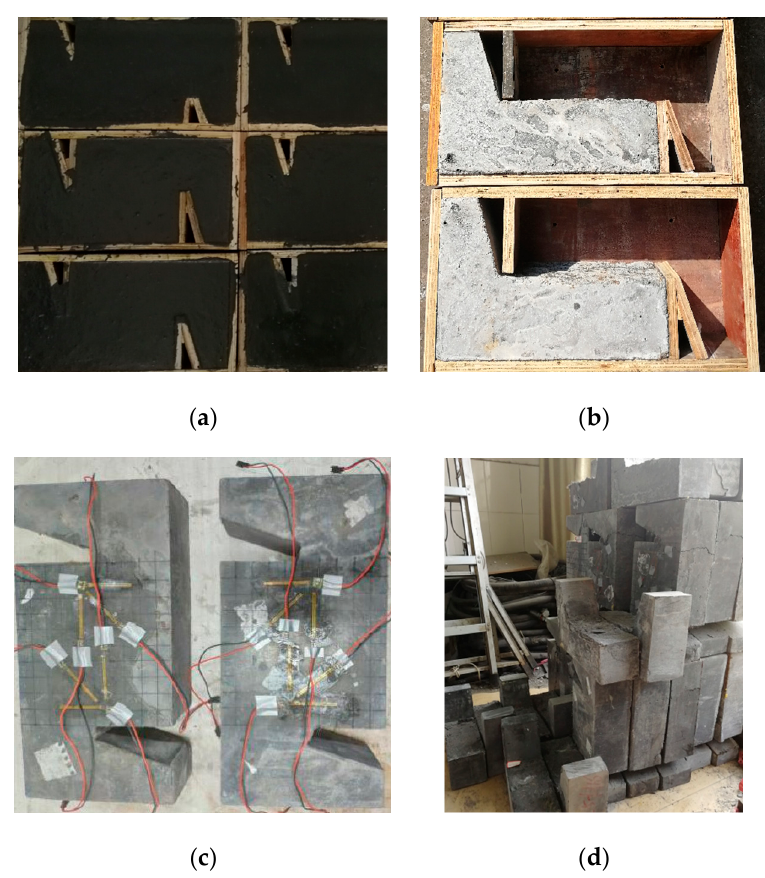
Figure 3. Manufacturing of Z-shaped specimens: ( a ) monolithic placement specimens (MPSs), ( b ) waterjet treated specimens (WJTSs), ( c ) finished specimens after maintenance and ( d ) all completed specimens.